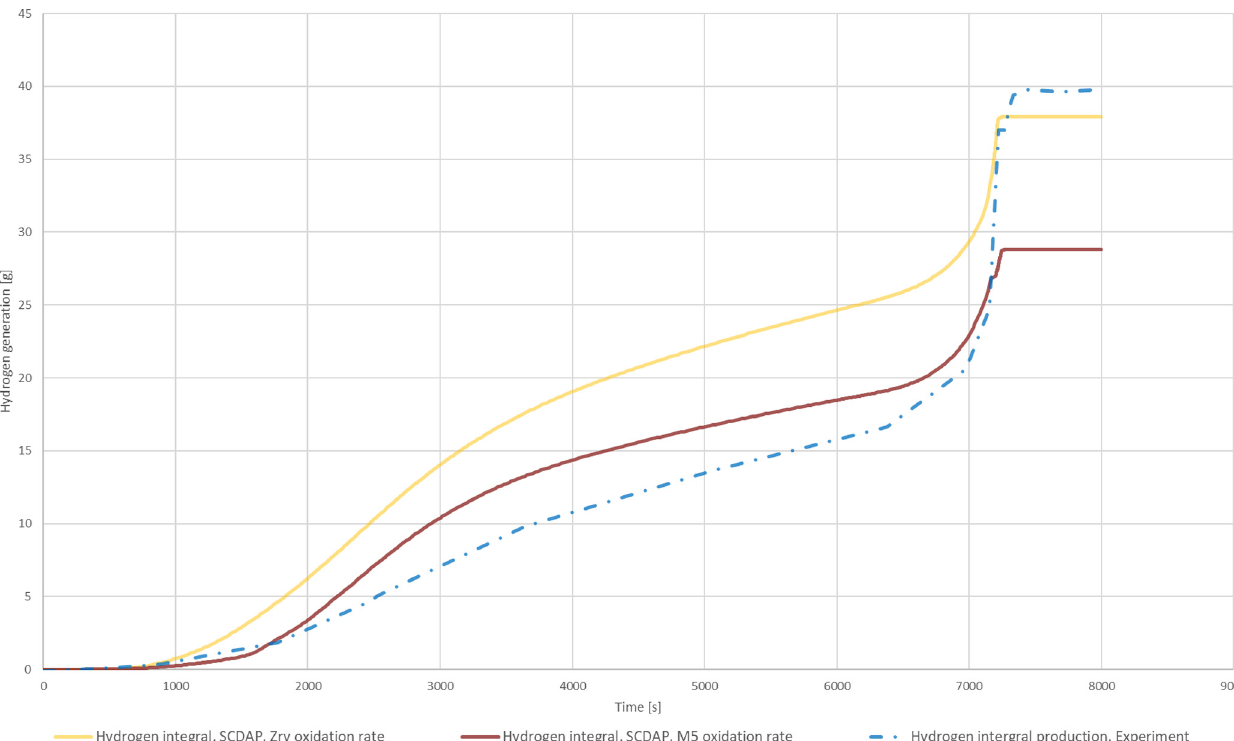
Fig. 8. Comparison of integral hydrogen production.